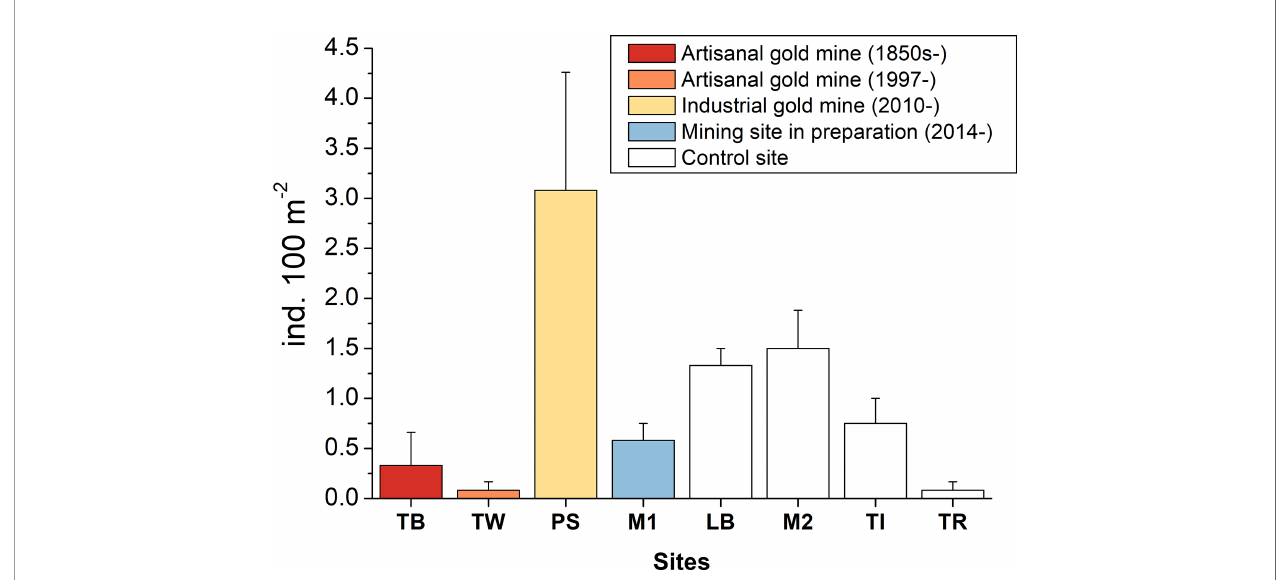
FIGURE 3 | Mean density (± s.e.) of H. atra at each study site: TB, Totok Bay; TW, Talawaan River; PS, Pantai Surabaya; M1, West Bangka mangroves; LB, Lihunu Bay; M2, North-west Bangka mangroves; TI, Tumbak Island; TR, Tasik Ria